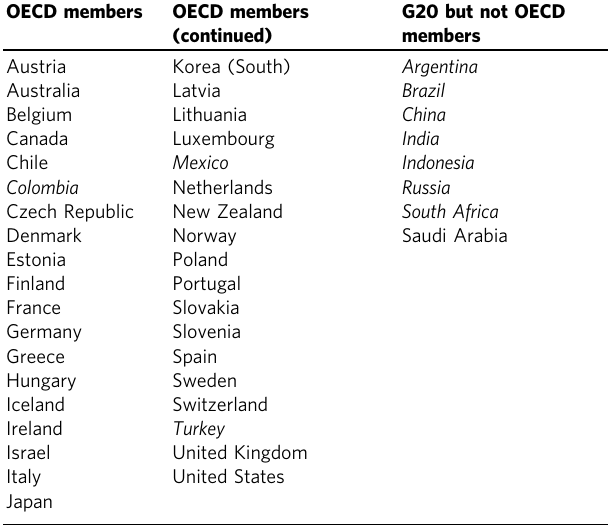
Table 2 Countries included in the